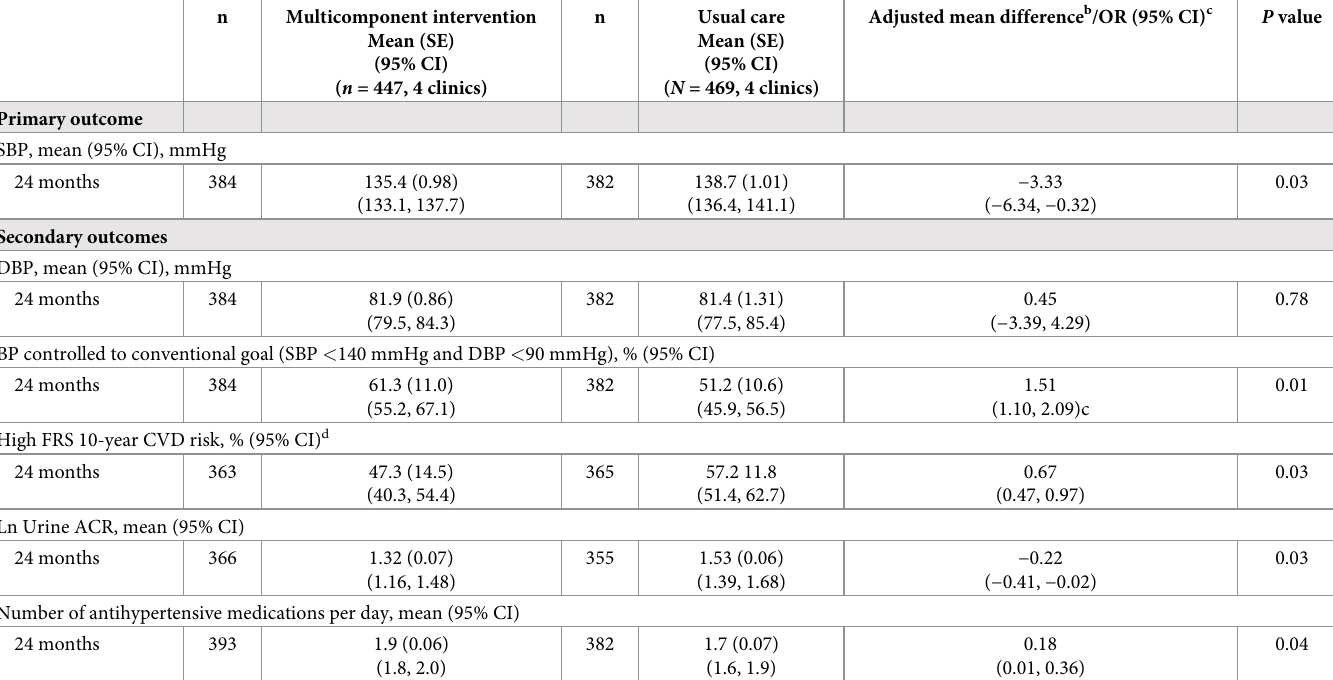
Table 2. Primary and BP-related key secondary outcomes by treatment group a